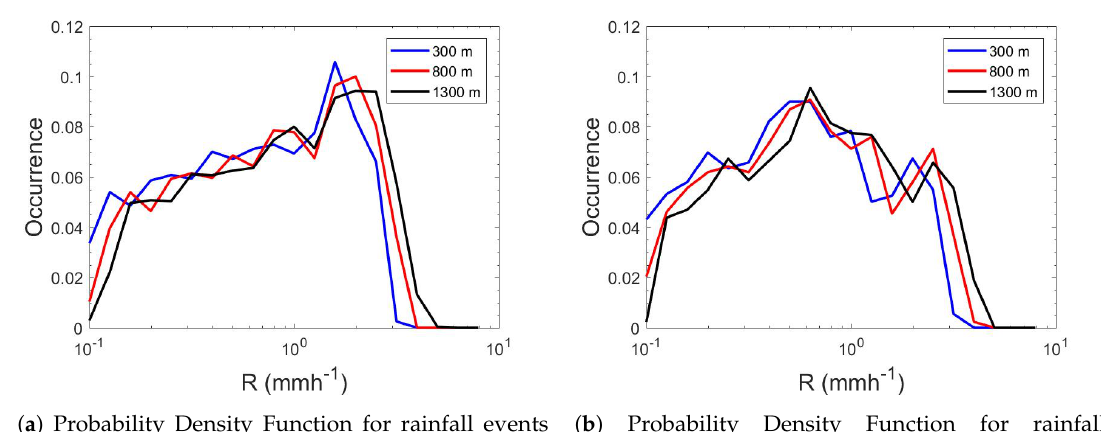
Figure 1. Probability Distribution Function (PDF) for rainfall intensities at three vertical levels (300 m, 800 m, 1300 m) during Spring ( a ) and Fall ( b ) 2016 at the MPLNET Barcelona permanent observation